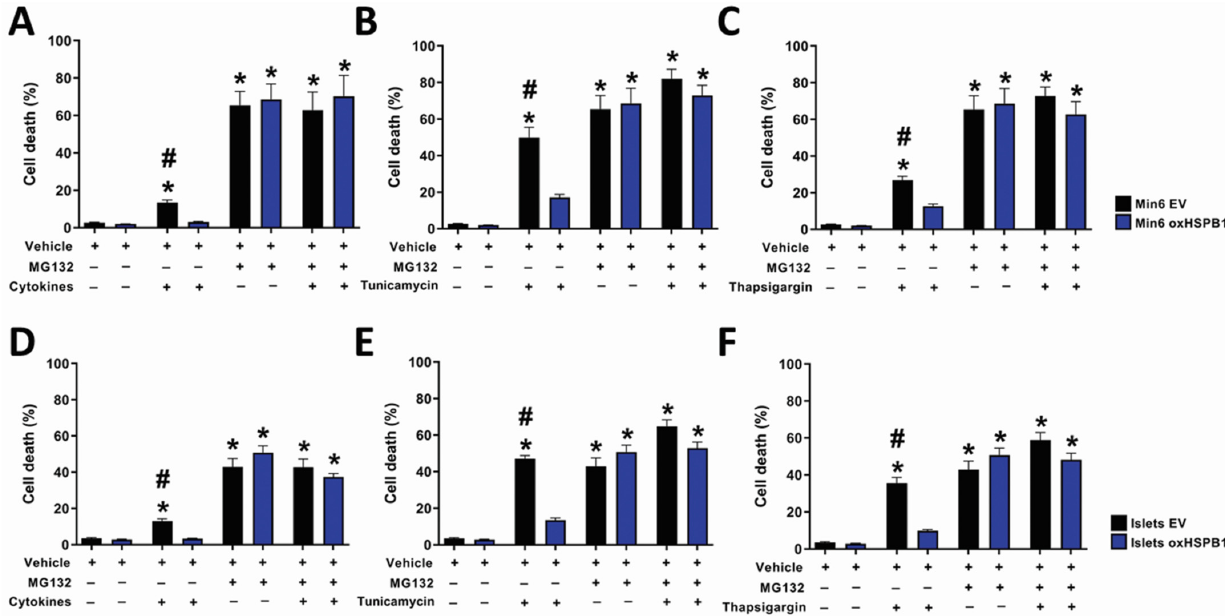
Figure 3. Proteasomal activity is essential for the cytoprotective effect of HSPB1 against cytokine-, tunicamycin- or thapsigargin-induced cell death. ( A – C ) HSPB1-overexpressing Min6 cells and ( D – F ) mouse islets (Min6 oxHSPB1, Islets oxHSPB1) and their respective controls (Min6 EV, Islets EV) were submitted to serum starvation (0.1% FCS) and then exposed to a combination of ( A , D ) cytokines (TNF- α 8 ng/mL, INF- γ 16 ng/mL, IL-1 β 1.6 ng/mL), ( B , E ) tunicamycin (15 or 7.5 µg/mL respectively), or ( C , F ) thapsigargin (75 nM) in the presence or absence of MG132 (2 µM) for 16 h. Cell death was evaluated by PI/Hoechst staining using fluorescent microscopy. Each data point represents the mean ± SEM from three replicates and at least three independent experiments carried out for each cell type submitted to the different cell incubation conditions; * p < 0.05 vs. control (vehicle); # p < 0.05 vs. oxHSPB1 respective treatment.